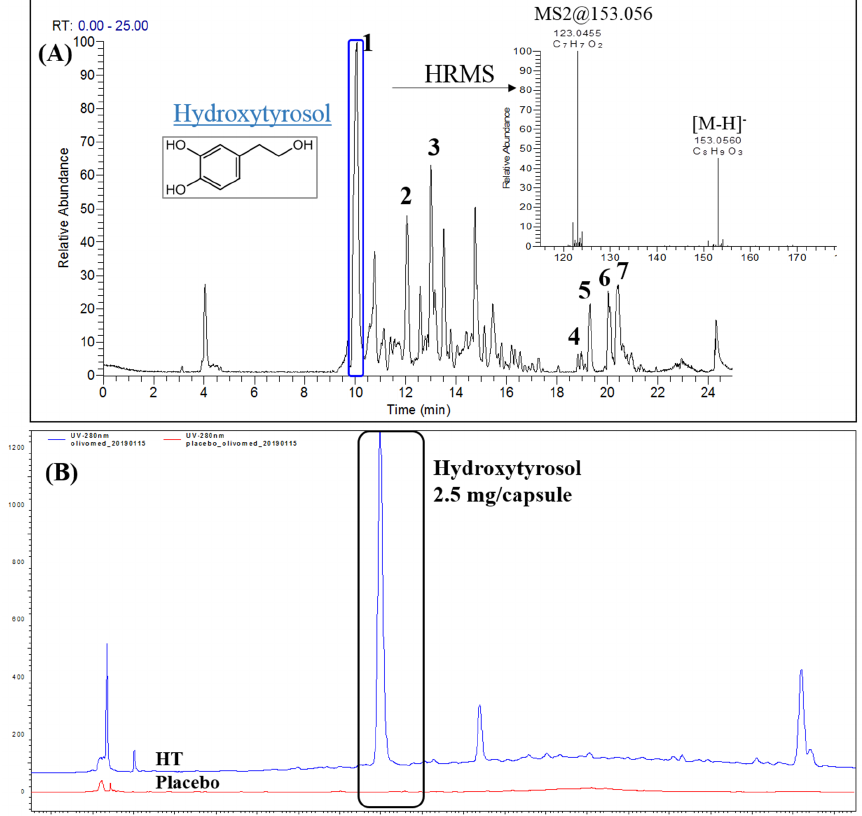
Figure 1. ( A ) Base peak (BP) chromatogram of the hydroxytyrosol (HT) capsule extract. Annotated peaks 1–7 correspond to the identified metabolites in the extract. On the right side of the chro- matogram, the high-resolution mass spectrometry (HRMS) spectrum of HT is presented. [M-H] - corresponds to the pseudomolecular ion of HT in negative ionization and its characteristic on-source fragment ( m / z 123.0455). ( B ) High-performance liquid chromatography–diode-array detection (HPLC-DAD) chromatogram at 280 nm of hydroxytyrosol (HT) capsule (blue) and placebo capsules (red) after dialysis in stomach conditions. The HT peak is